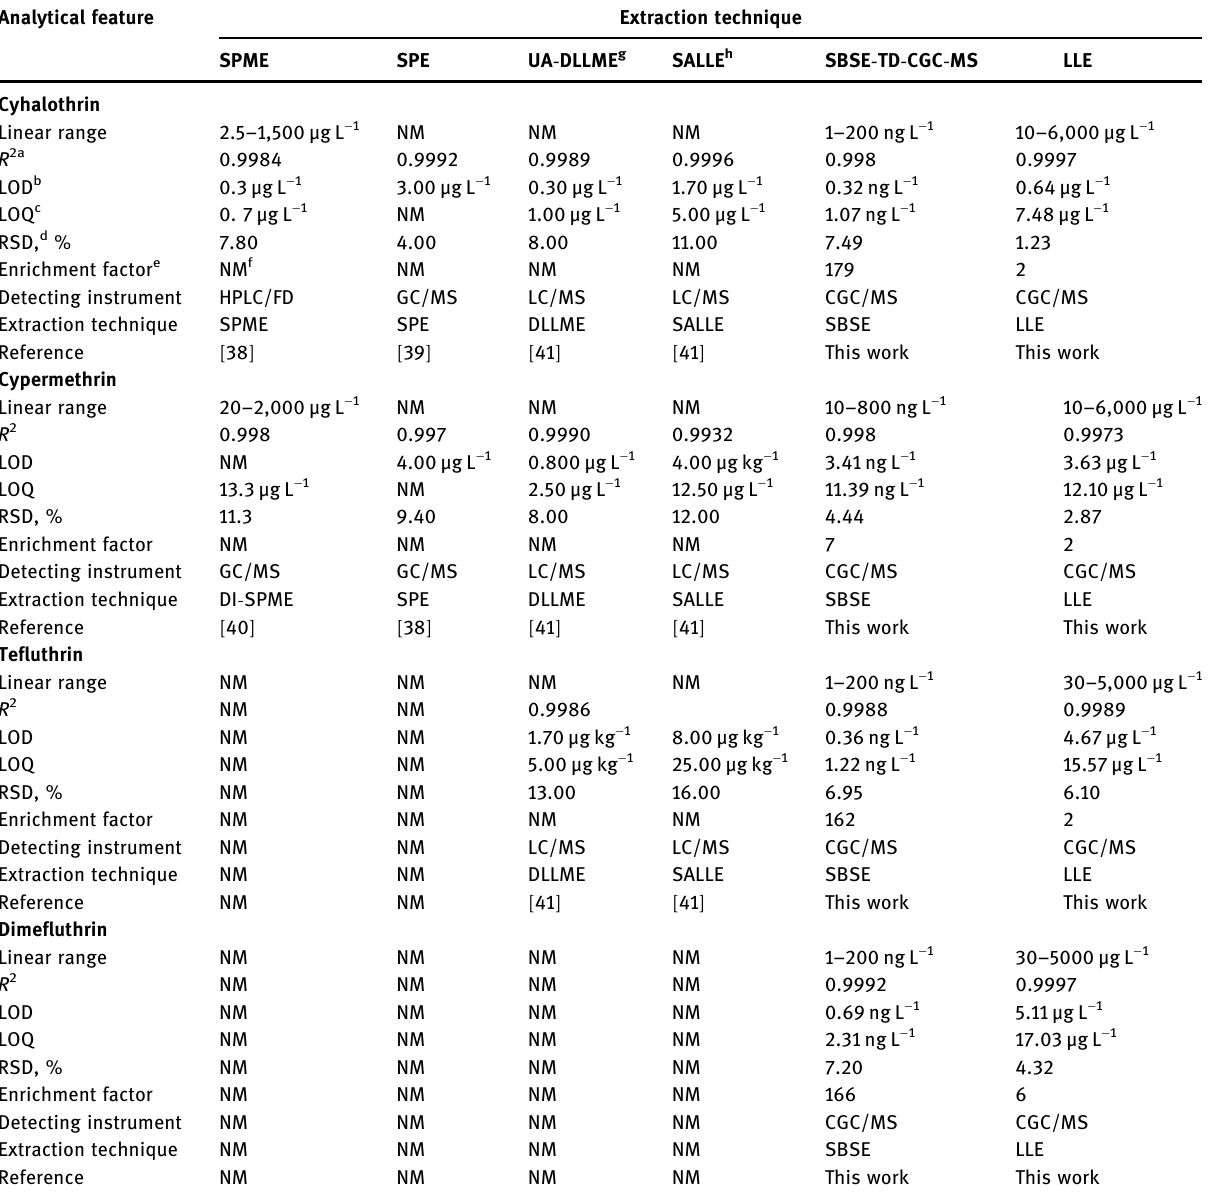
Table 2: Analytical fi gures of merit for determination of four target pesticides by SBSE - TD - CGC - MS and LLE and comparison with other methods proposed for their analysis in water